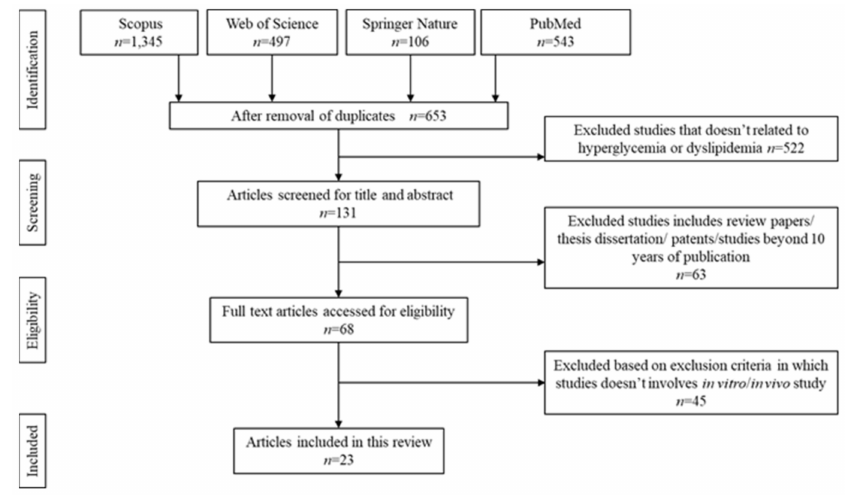
Figure 1. Identification and screening for literature